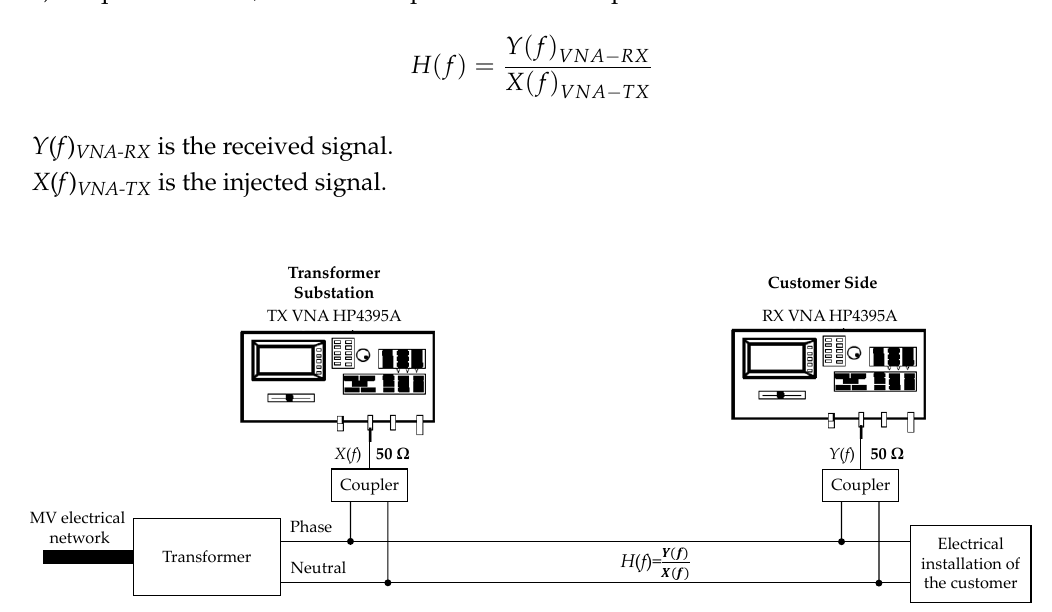
Figure 7. Transfer function measurement setup.